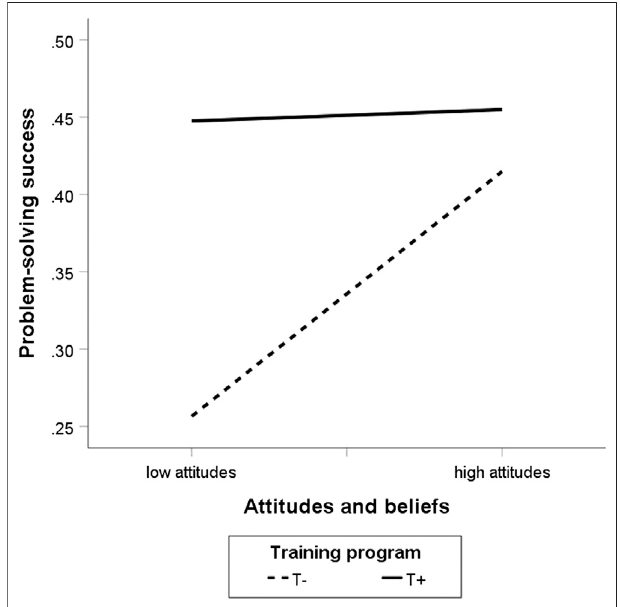
FIGURE2| Moderatoreffect ofthetrainingprogramonproblem-solving success at Measurement Point